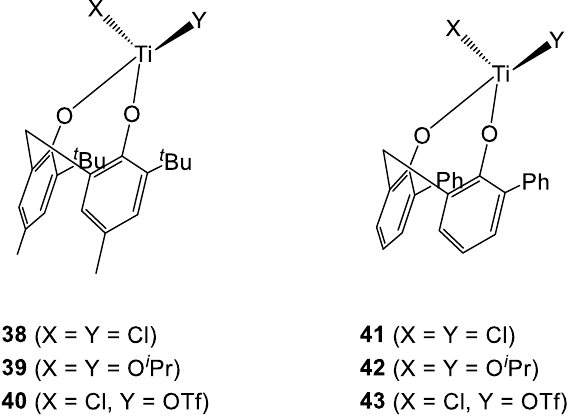
Figure 11. Diphenolate complexes employed in ROP of oxocyclic monomers [22,23].